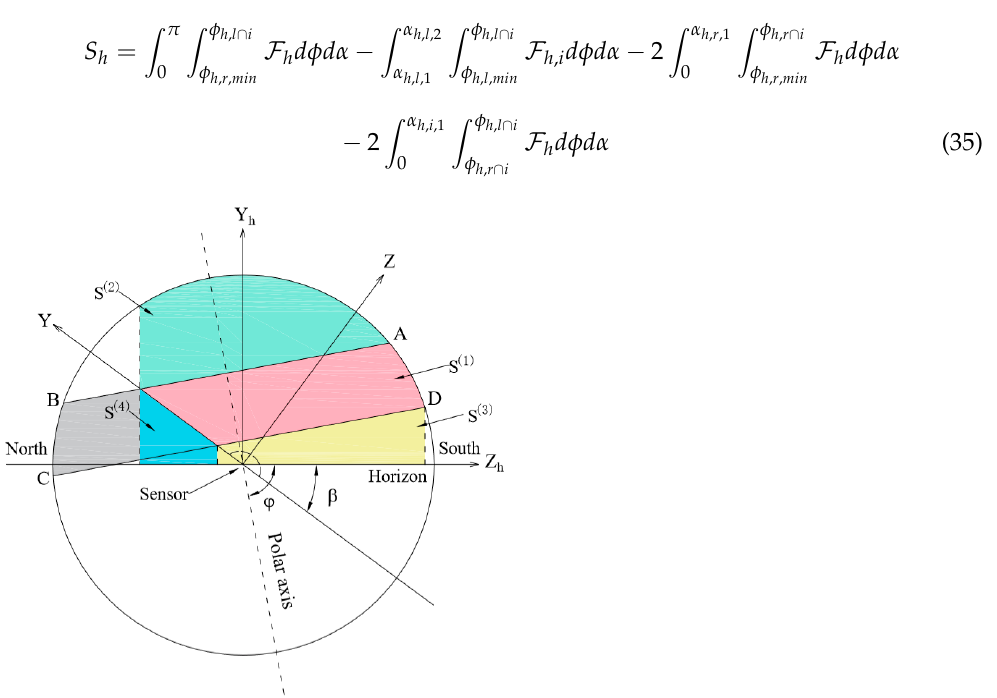
Figure 12. Schematic diagram for the calculation of S h while d r ≤ 0, φ h , l , max ≥ φ h , l ∩ i ≥ φ h , l , min , φ h , r , max ≥ φ h , r ∩ i ≥ φ h , r , min .